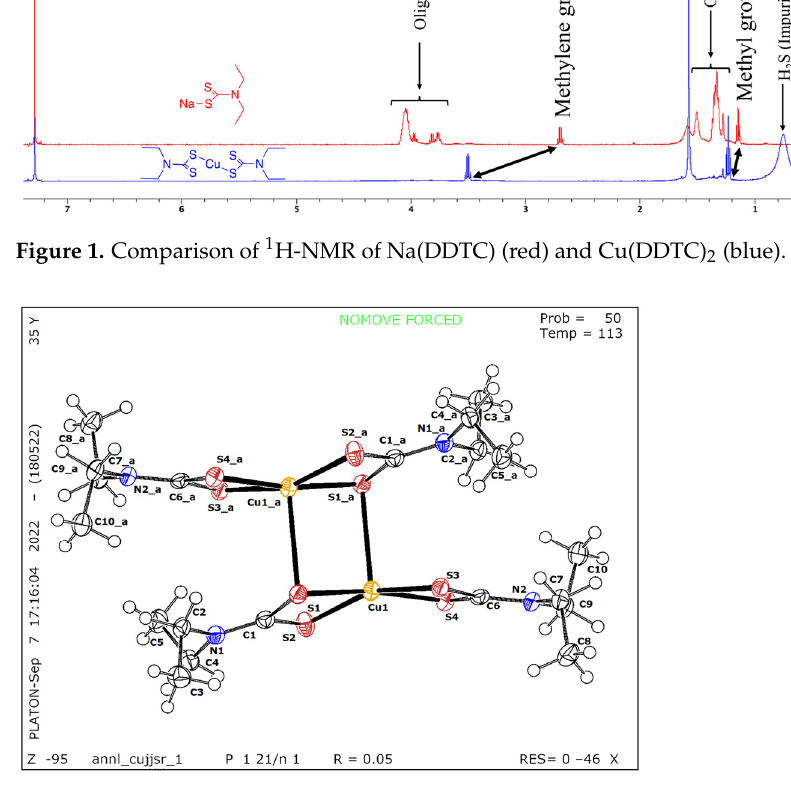
Figure 2. Crystal structure of Cu(DDTC) 2